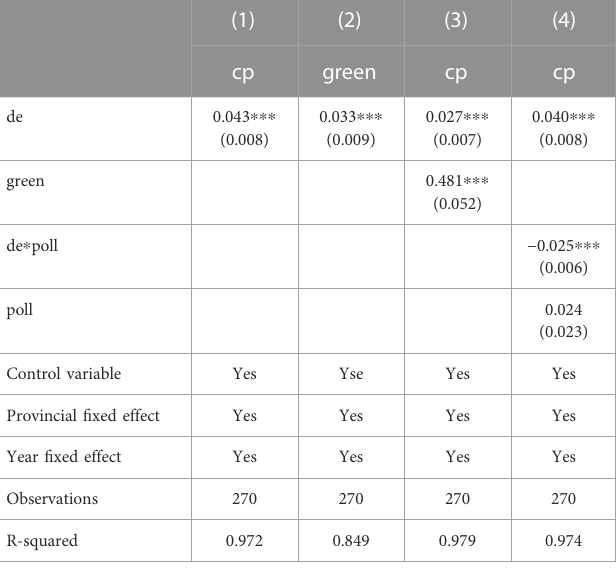
Table 6, that the higher the level of the digital economy, the higher the level of common prosperity of the province, which is signi fi cantly positively correlated, and α 1 = 0.043 is the total effect of the independent variable on the dependent variable.